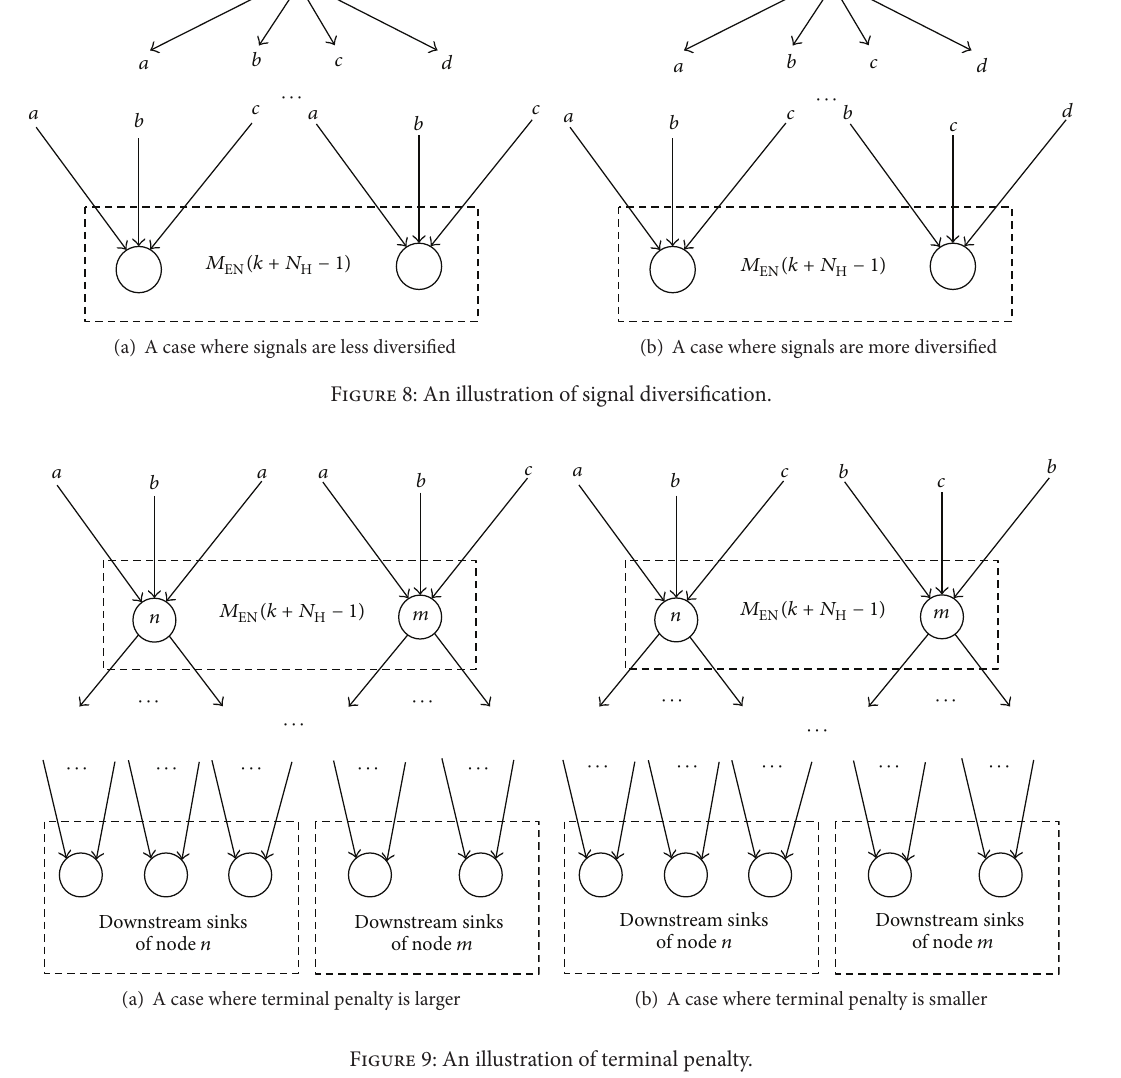
Figure 9: An illustration of terminal